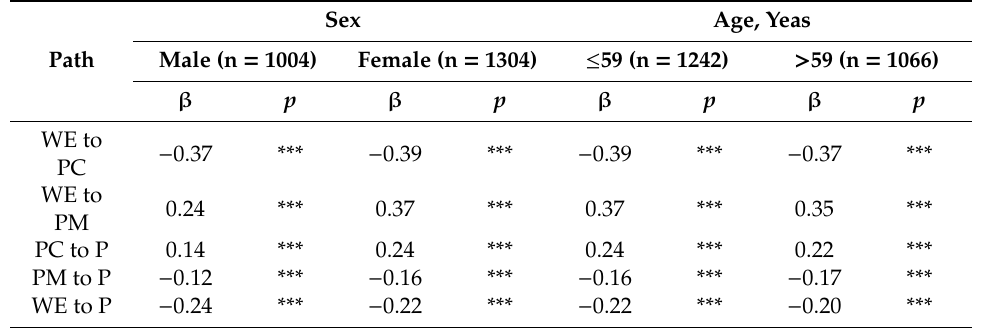
Table 4. Standardized regression weights ( β ) with p -values for the components of subgroup